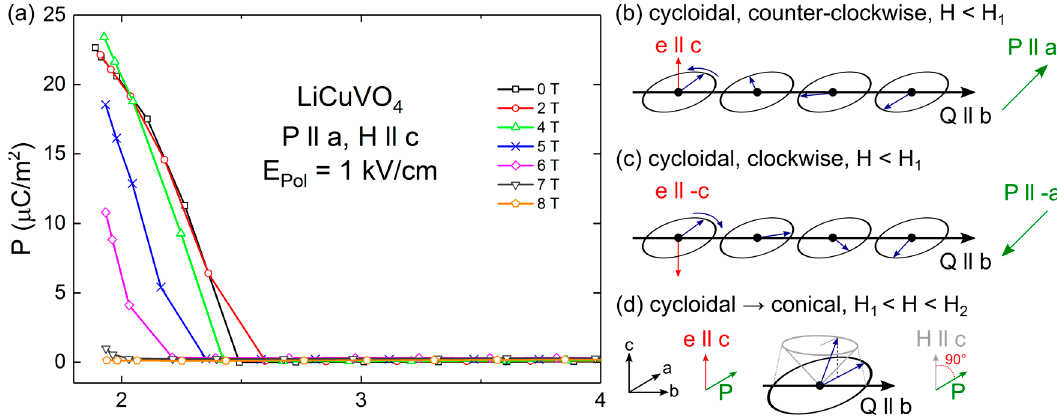
Figure 1. ( a ) Temperature dependent polarization along the a direction of a LiCuVO 4 single crystal, measured during heating after a poling field of 1 kV/cm was applied while cooling. The pyrocurrent measurements were performed for various magnetic fields (up to 8 T) along the c direction; ( b – d ) illustrate possible spin-spiral configurations in LiCuVO 4 , also including the directions of polarization, applied magnetic field, spiral-axis and the modulation direction of the spin-spiral.